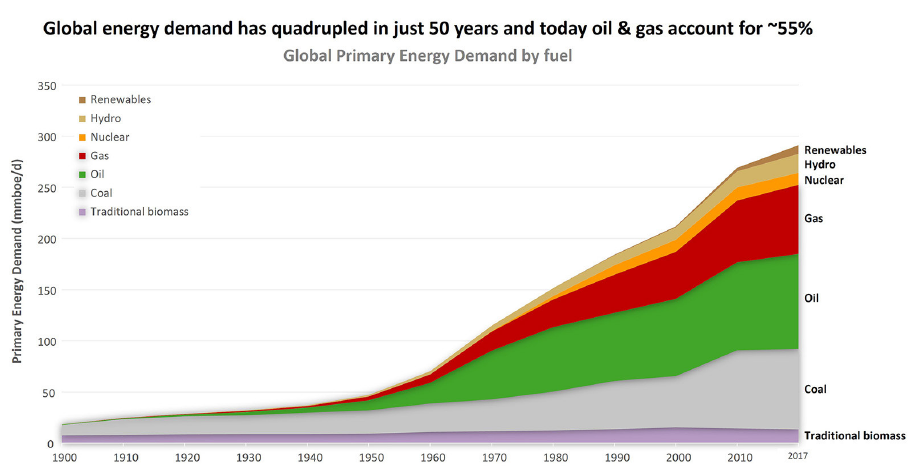
Fig. 3. – Global Primary Energy Demand by fuel type in mmboe/d between 1900 and 2017 (Source: Eni S.p.A.).